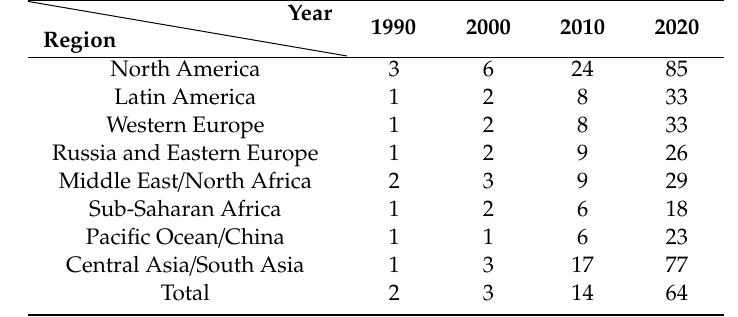
Table 4. Solar energy utilization and development forecast in major regions of the world. (unit: oil equivalent